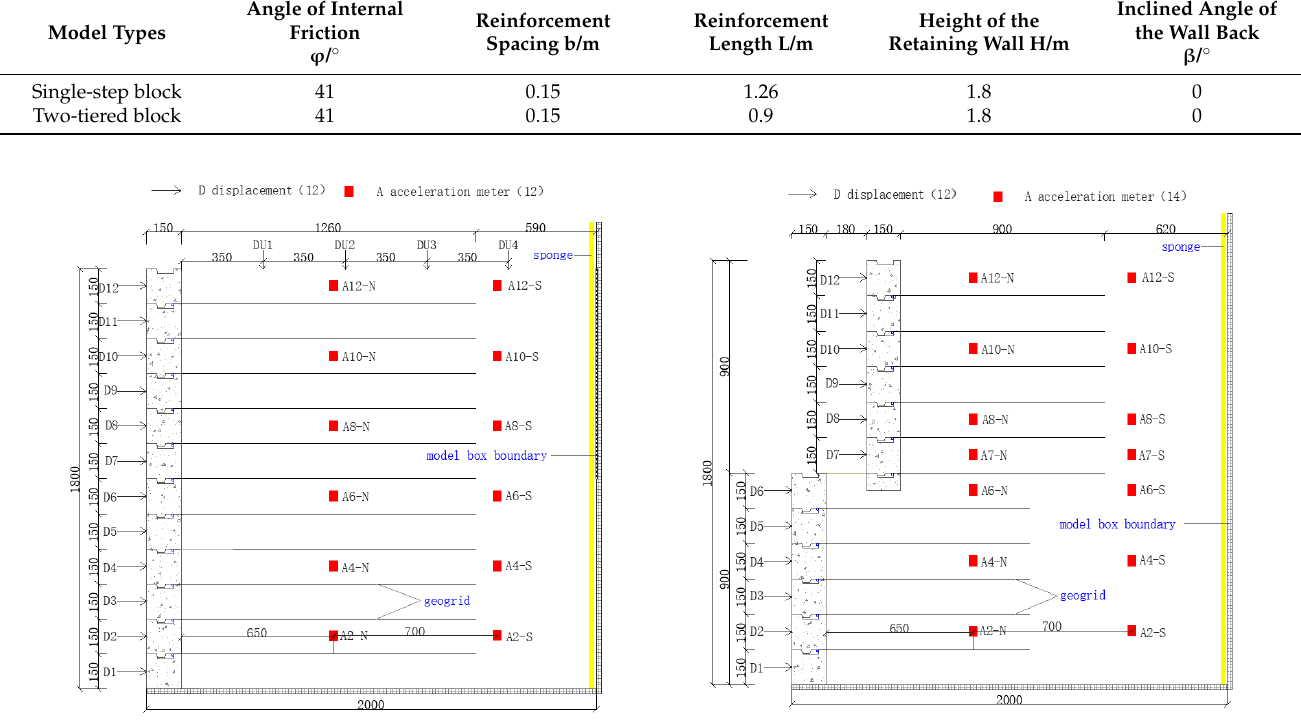
Figure 8. Model plane diagram. Table 3. Calculation and test parameters.